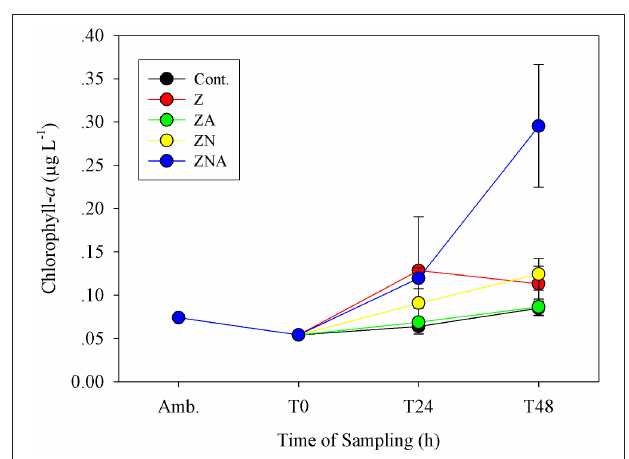
FIGURE 2 | Measured changes in chlorophyll- a concentration in the microcosm treatments compared with the initial ambient values of the water used to inoculate the microcosm bottles.